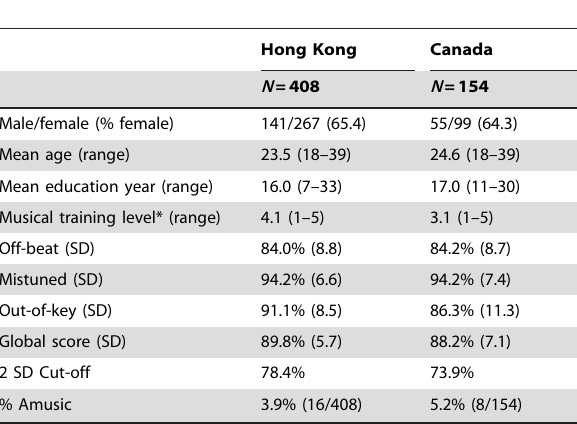
Table 1. Comparison of Hong Kong and Canadian Younger Participants (18–39 years old